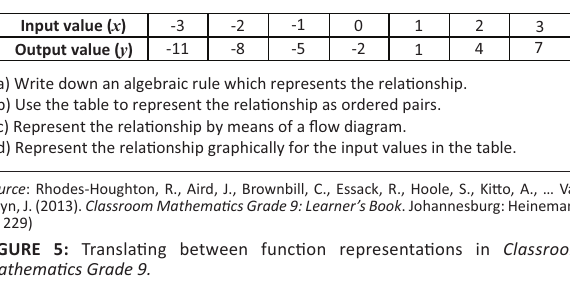
FIGURE 5: Translating between function representations in Classroom Mathematics Grade